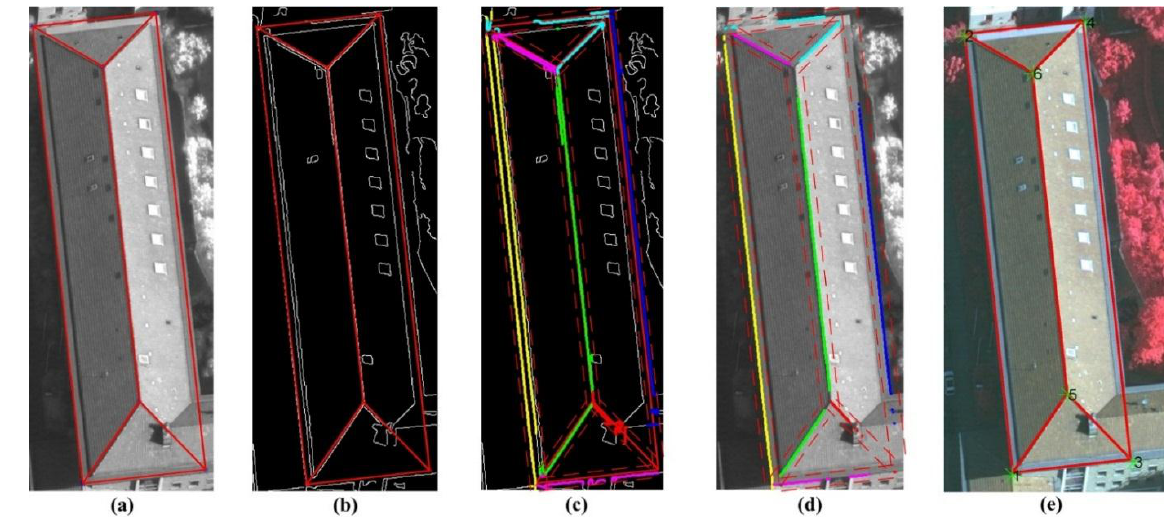
Figure 9. The process of corner extraction from aerial imagery. ( a ) Initial model back projected onto the corresponding aerial imagery; ( b ) initial model superimposed onto the edge map; ( c ) edge pixels in the buffer zone; ( d ) inliers of RANSAC superimposed onto the gray image; and ( e ) the extracted 2D